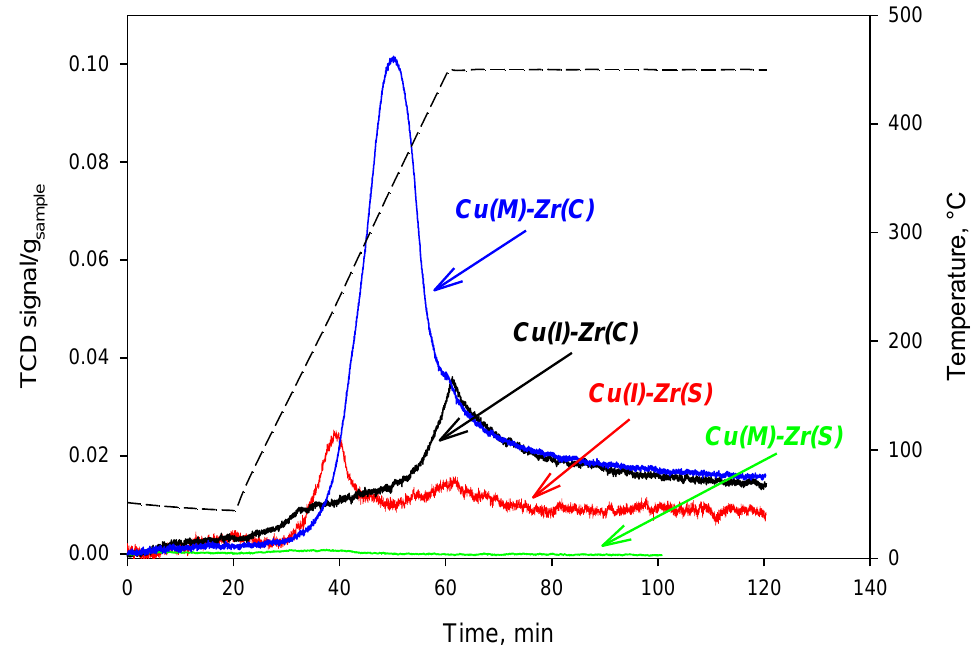
Figure 4. Profiles of H 2 -TPR tests over used samples.